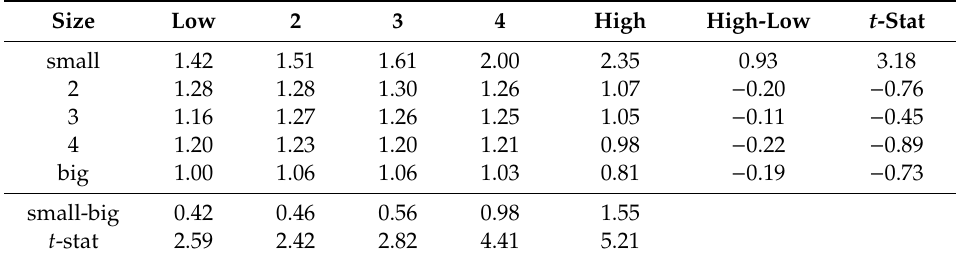
Table 8. Average returns from double-sorted quantile portfolios (sorted by size and Geske’s total default probability). From the data for July 1963 to December 2013, at the end of each month, stocks are independently sorted into 5 × 5 portfolios based on size and Geske’s total default probability. The table shows average returns for each of 25 portfolios. Small-big is the return di ff erential between the small and big firm portfolios within each default quantile. High-low is the return di ff erential between the high and low default probability firms within each size quantile. t -statistics are calculated using Newey-West standard